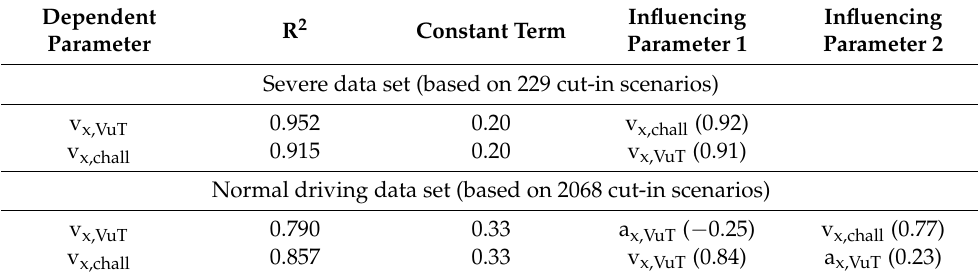
Table 4. Relevant regression models from severe and exposure data subsets.